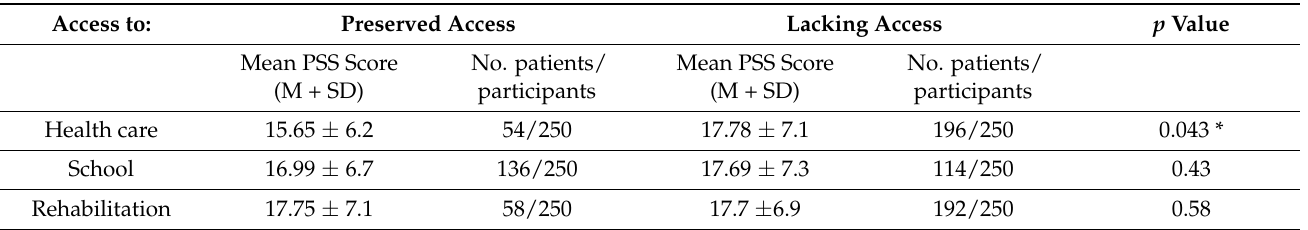
Table 3. A comparison of the Perceived Stress Scale mean score among the parents related to the presence of health care, remote schooling, and remote rehabilitation during the lockdown.